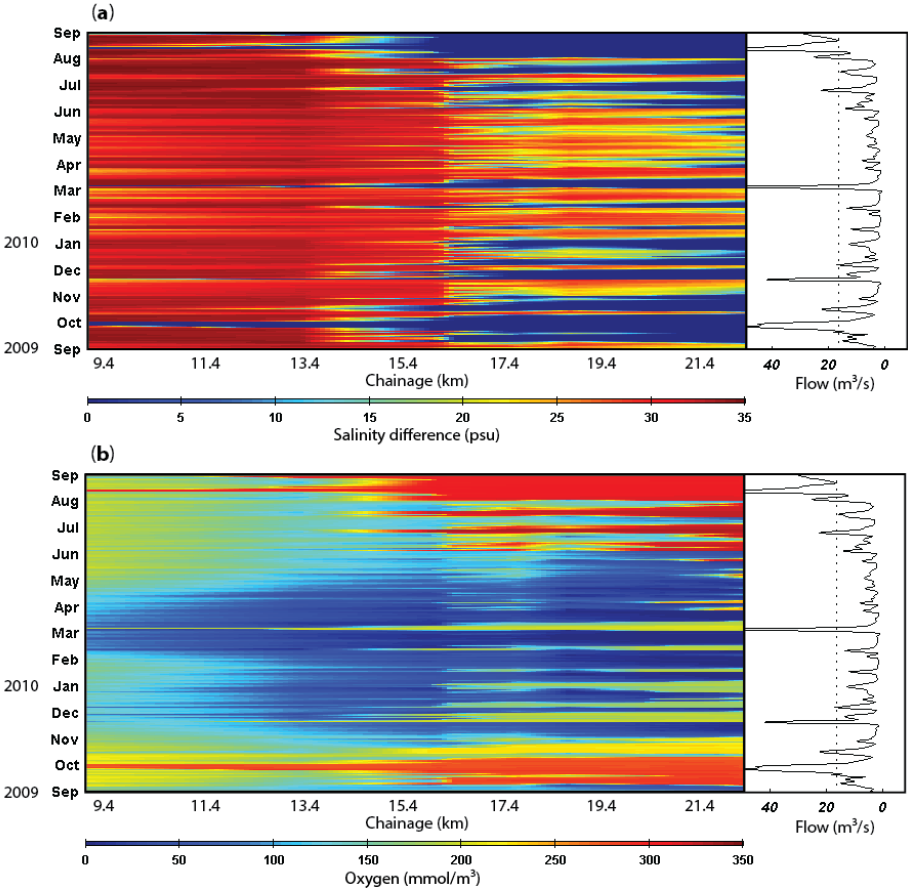
Fig. 6. Predicted (a) strength of stratification (bottom cell – top cell, psu) and (b) bottom oxygen concentration (mmolm − 3 ) . Right panels represent average daily flow rate (m 3 s − 1